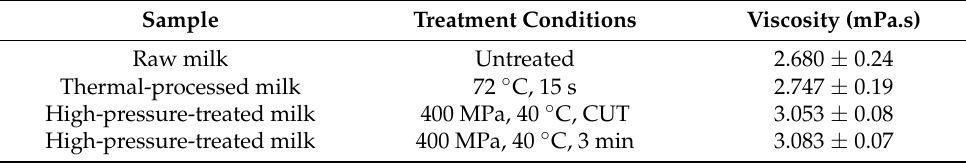
Table 6. Viscosity of milk processed with different preservation methods